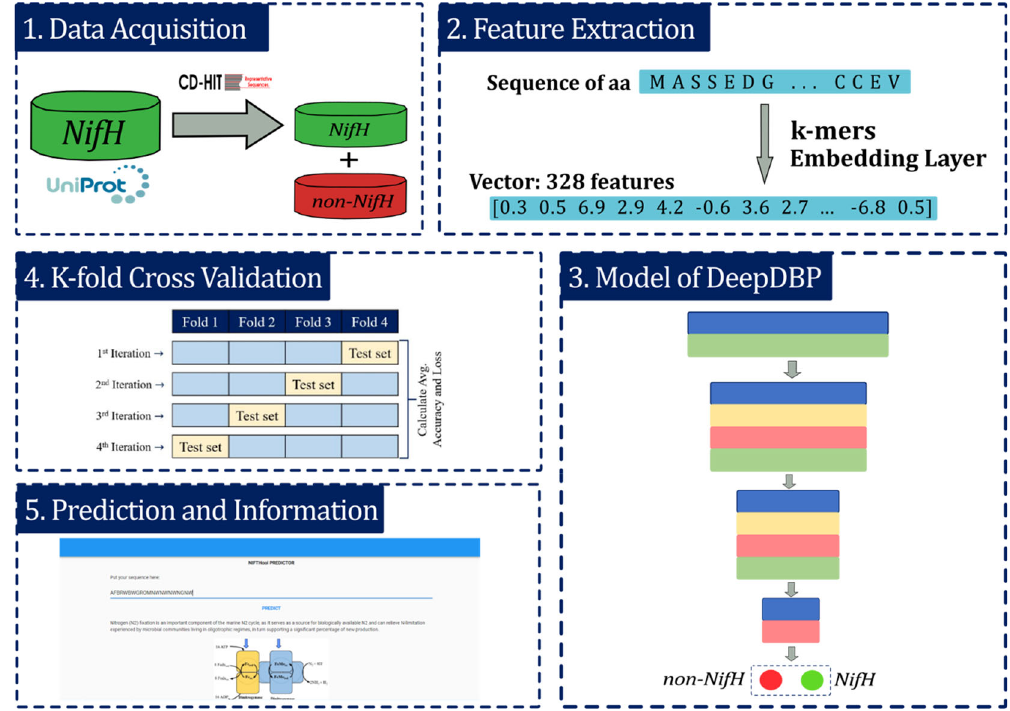
Figure 2. Description of the methodology applied in this work. i) Data acquisition, ii) Feature extraction, iii) Modeling of deep learning, iv) K-fold Cross-validation and v) prediction and providing information. Dinitrogenase reductase =